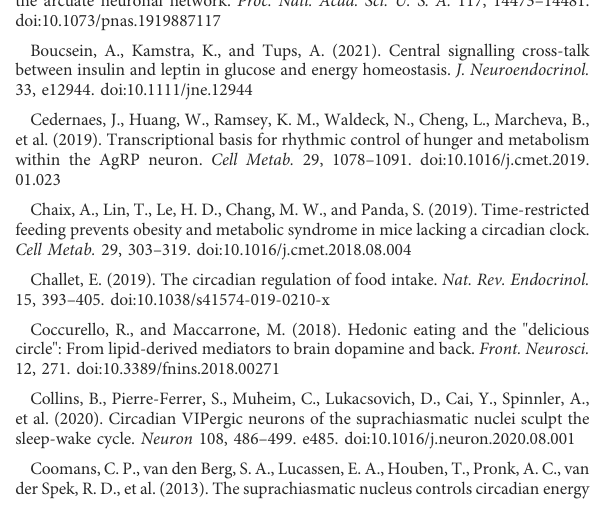
Speci fi c removal of GABA receptor A subtypes from the PVN region. (A) Injection of an AAV expressing Cre recombinase and eGFP into the PVN of control or Gabra1 fl oxed mice. ×10 objective (numerical aperture = 0.3, dry), a white bar measures 75 μ m. (B) Detection of Gabra1 (Cy3, magenta) in the mouse strains and colocalization with the Cre recombinase (eGFP, green). ×63 objective (numerical aperture = 1.3, glycerol), a white bar measures 15 μ m. (C) Injection of an AAV expressing Cre recombinase and eGFP into the PVN of control or Gabra2 fl oxed mice. ×10 objective (numerical aperture = 0.4, dry), a white bar measures 75 μ m. (D) Detection of Gabra2 (Cy3, magenta) in the mouse strains and colocalization with the Cre recombinase (eGFP, green). ×63 objective (numerical aperture = 1.3, glycerol), a white bar measures 15 μ m.